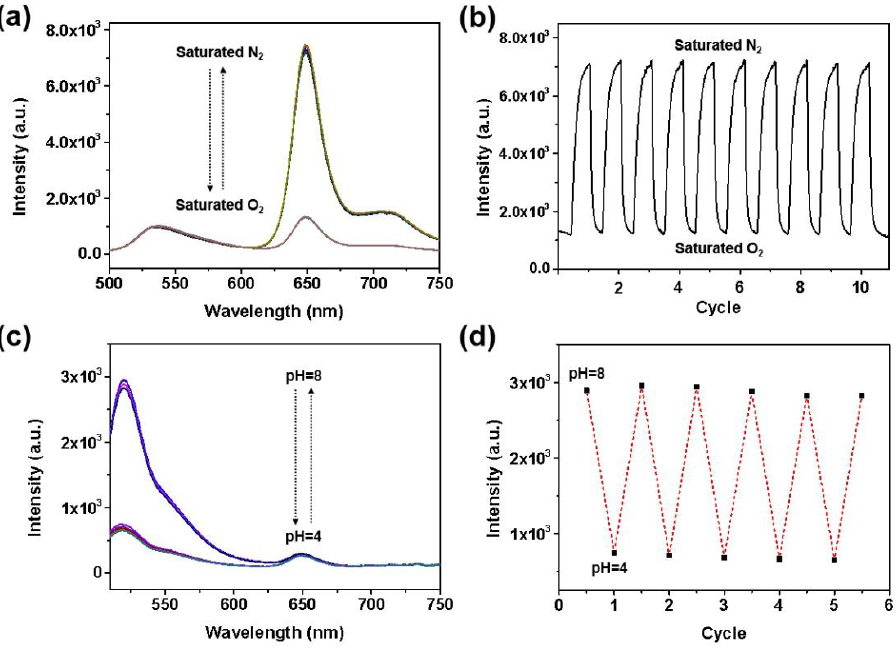
Figure 6. Reversibility of the dual sensing film. Emission spectra ( a ) and reversibility ( λ ex / λ em = 405 nm/650 nm) ( b ) of the F3 in O 2 -saturated and N 2 -saturated solutions, emission spectra ( c ) and reversibility ( λ ex / λ em = 488 nm/520 nm) ( d ) of F3 in BR buffer between pH 4.0 and pH 8.0.